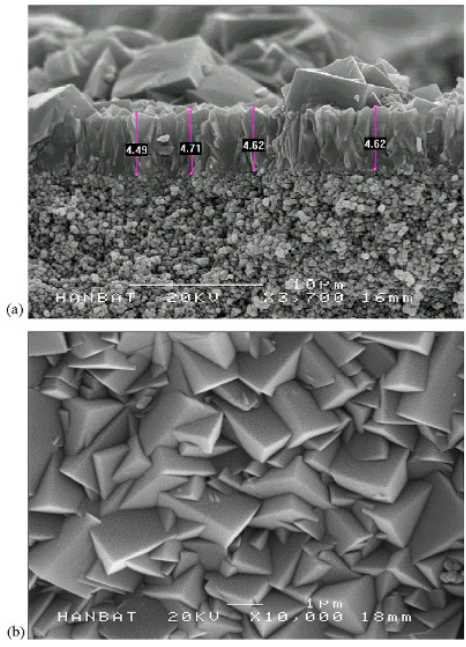
Figure 11. SEM images of the NaA zeolite membrane: ( a ) a cross-sectional view; ( b ) a top view [211] SEM image shows NaA and NaY zeolite crystals which are grown randomly with size of 1–2 µ m. the zeolite support layer thickness is about 5 µ m. Reproduced with permission from .